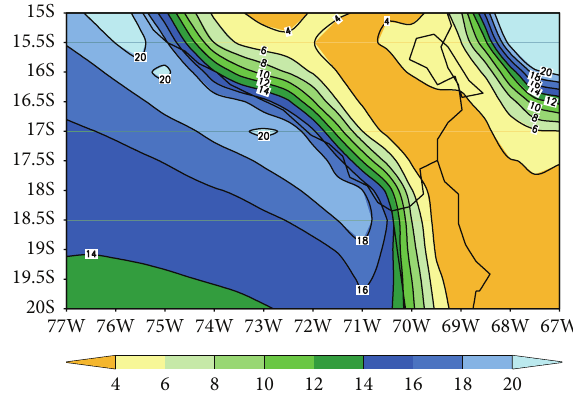
Figure 4: JJA CFS reanalysis climatology 1979–2009 dew point shaded and contoured (units: degrees C).